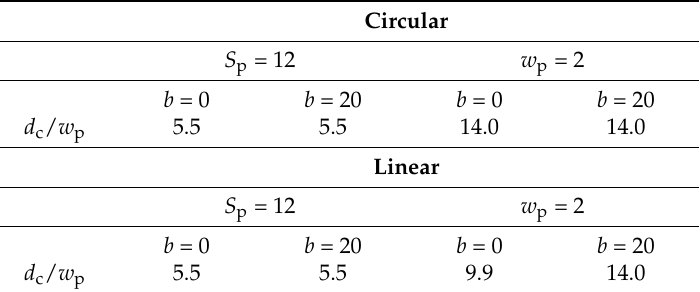
Table 2. Values of the ratio d c / w p under which the chains spread from single to multiple occupancy in the post arrays of the constant post separation S p and of the constant passage width w p